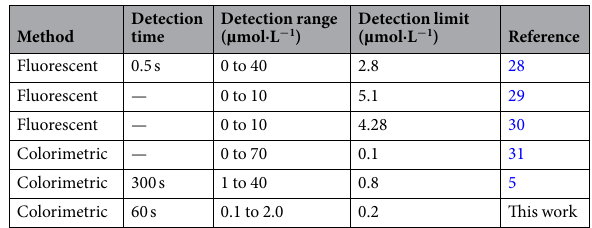
Table 1. Detection of Mg 2 + contents in a reasonable range according to the literature values reported using different